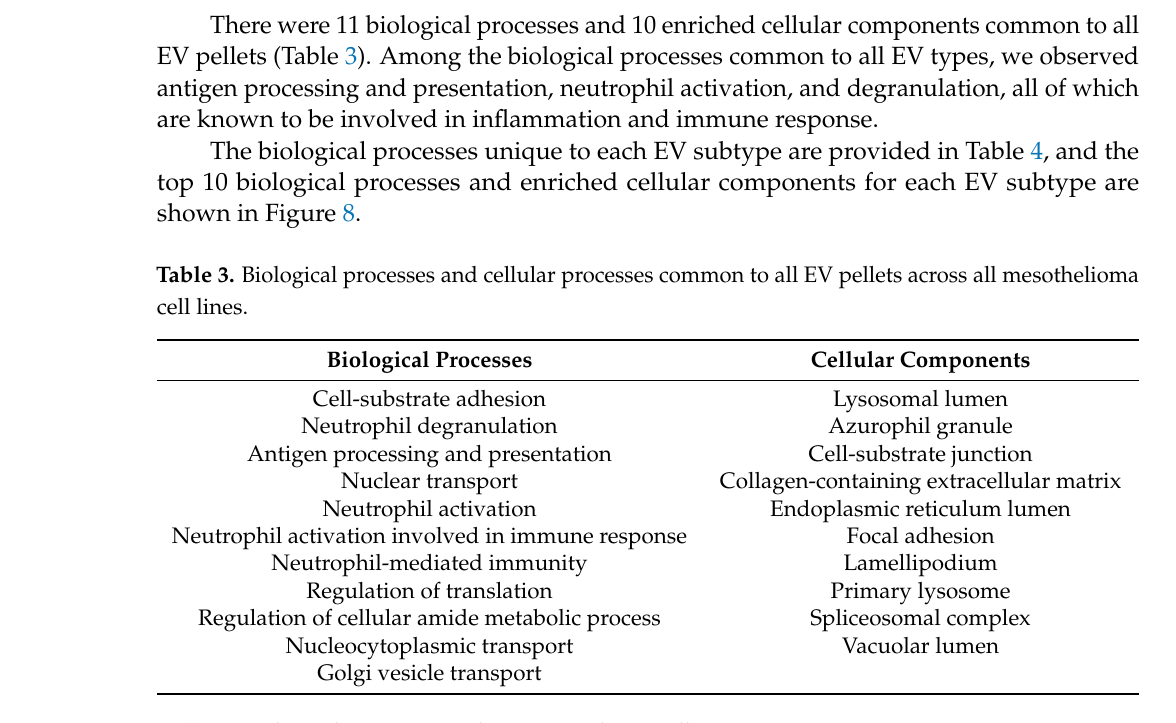
Figure 7. Focused heatmap showing the top overexpressed and underexpressed proteins present in the ( A ) 10 K EV ( B ) 18 K EV, and ( C ) 100 K EV subtypes across all pleural mesothelioma cell lines. Data obtained from four biological replicates.